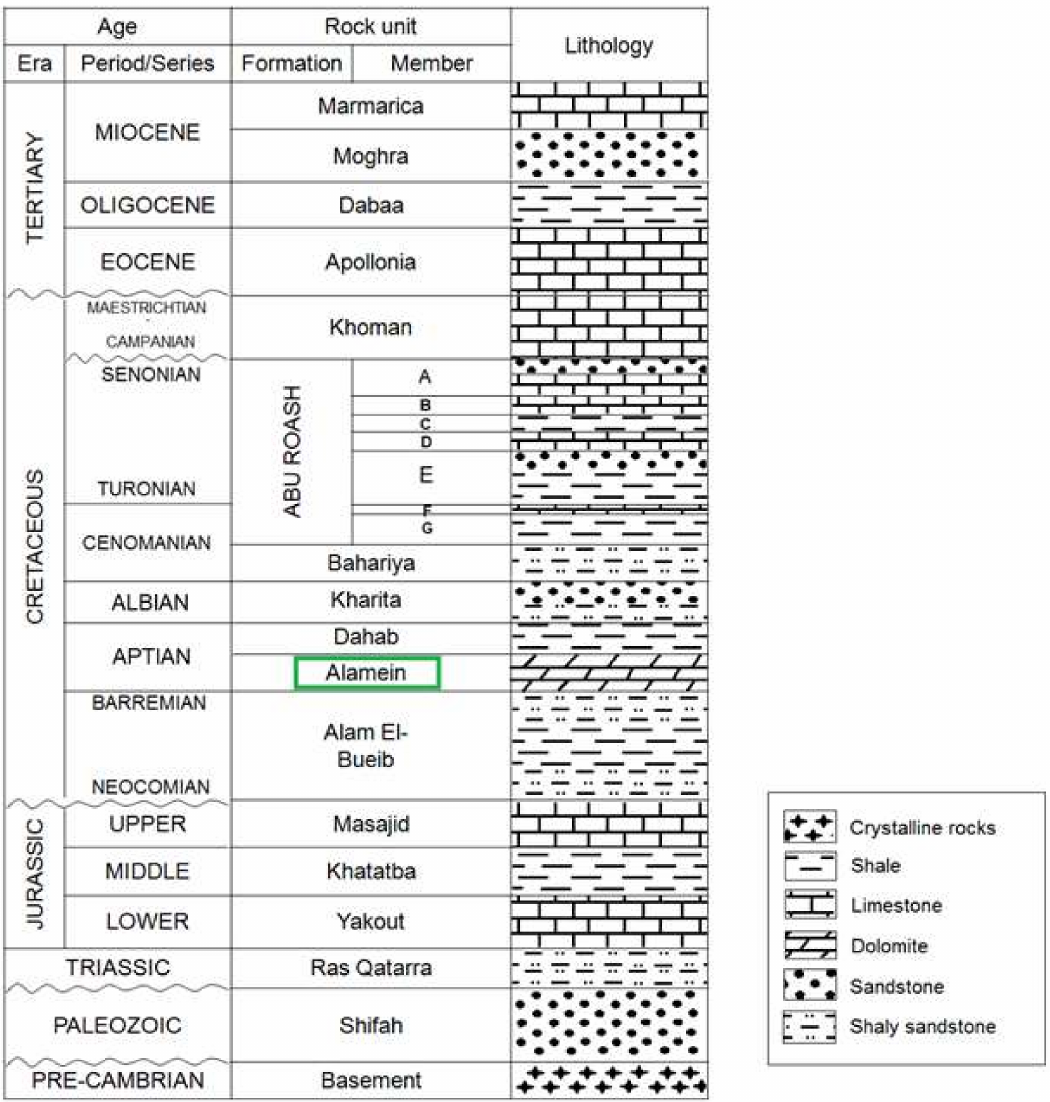
Figure 2. Litho-stratigraphic column of the north Western Desert of Egypt, modified version of